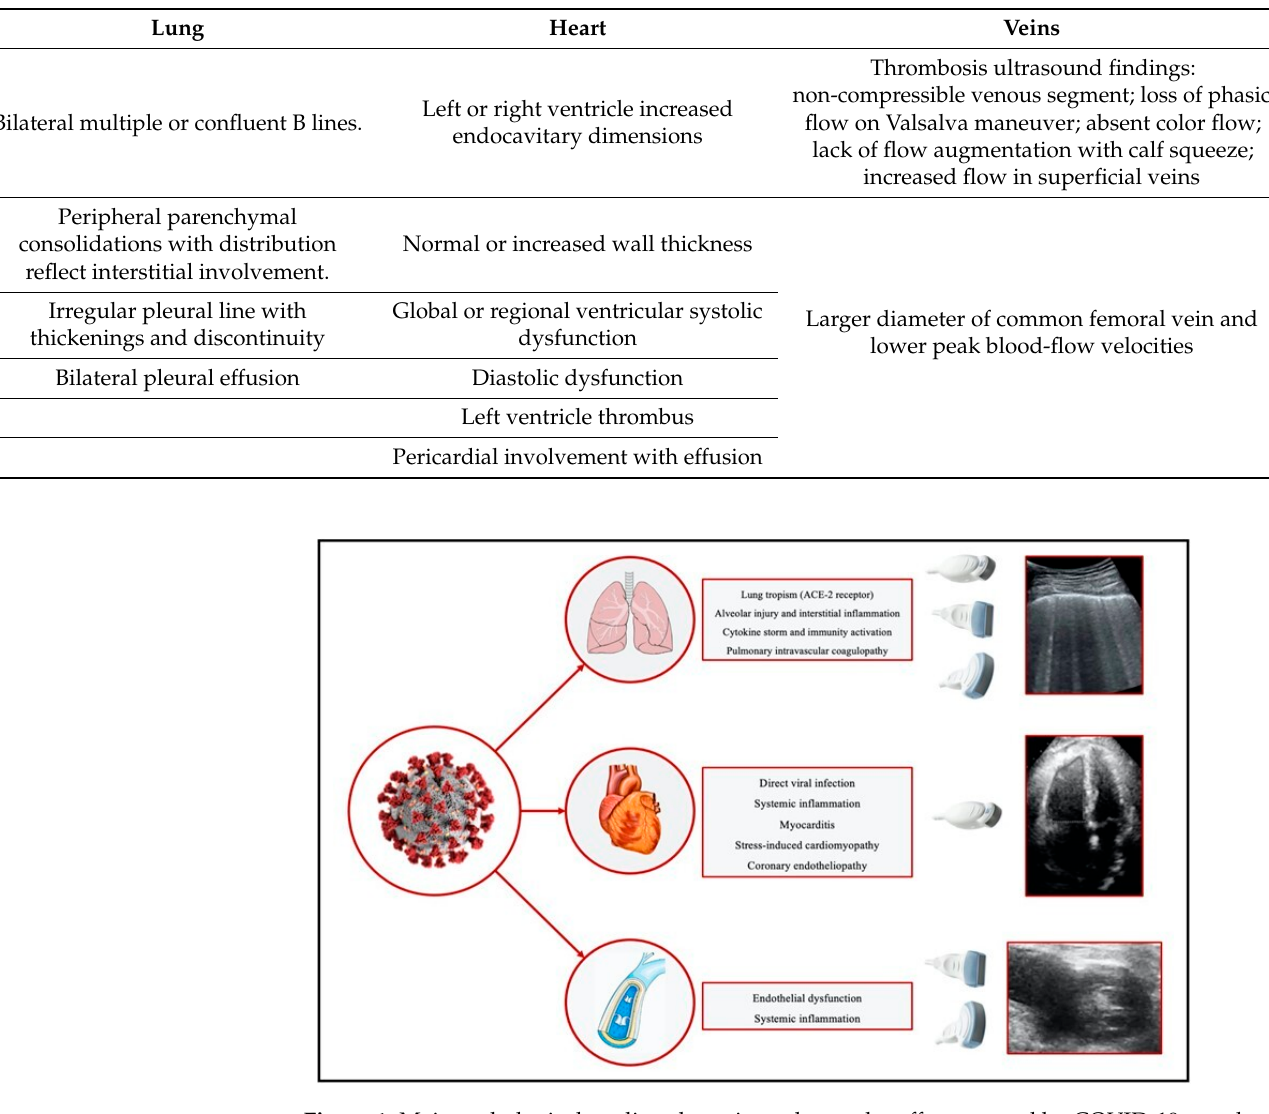
Figure 1. Main pathological cardiac, thoracic, and vascular effects caused by COVID-19 correlated with ultrasound changes. ACE: Angiotensin-converting enzyme